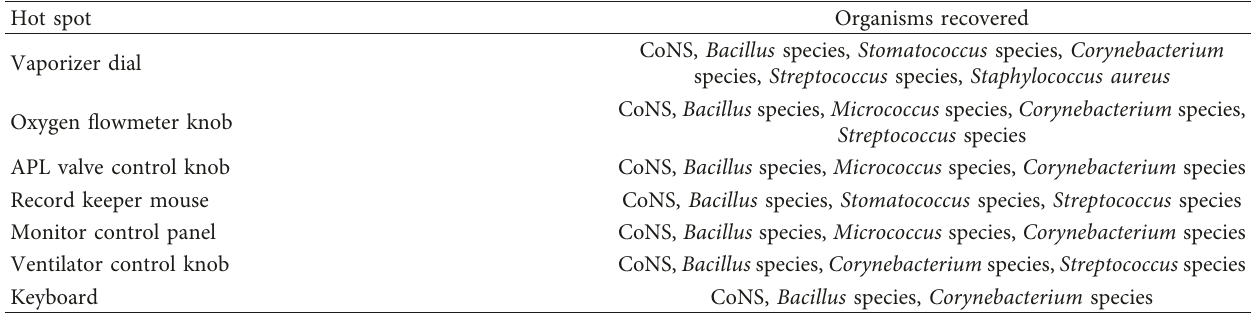
Table 1: List of bacterial species cultured on the anesthesia